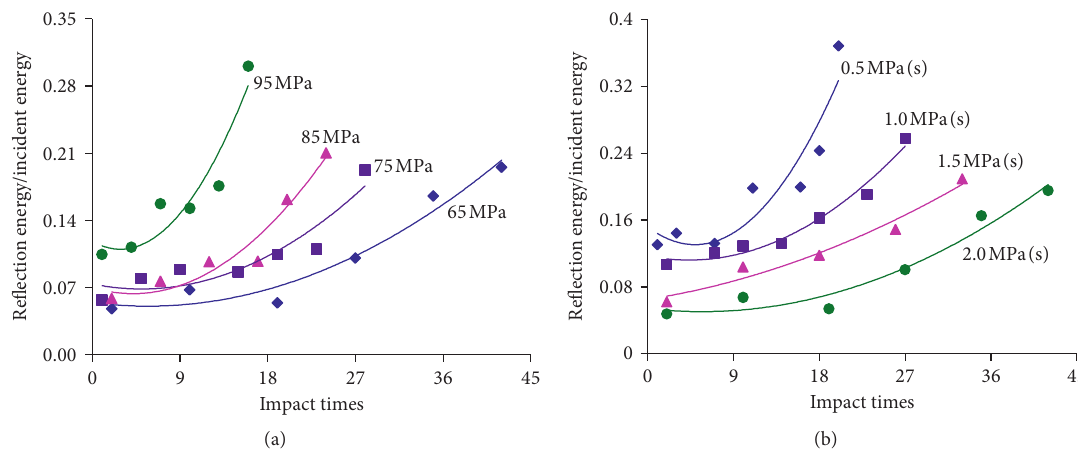
Figure 12: Change law of the ratio of reflection energy to incident energy with the increase of disturbance impact times: (a) unloading rate is 2.0MPa/s (the numbers in figure represents the preloaded axial static stress of specimen); (b) the preloaded axial pressure is 65MPa (the number in the figure represents the unloading